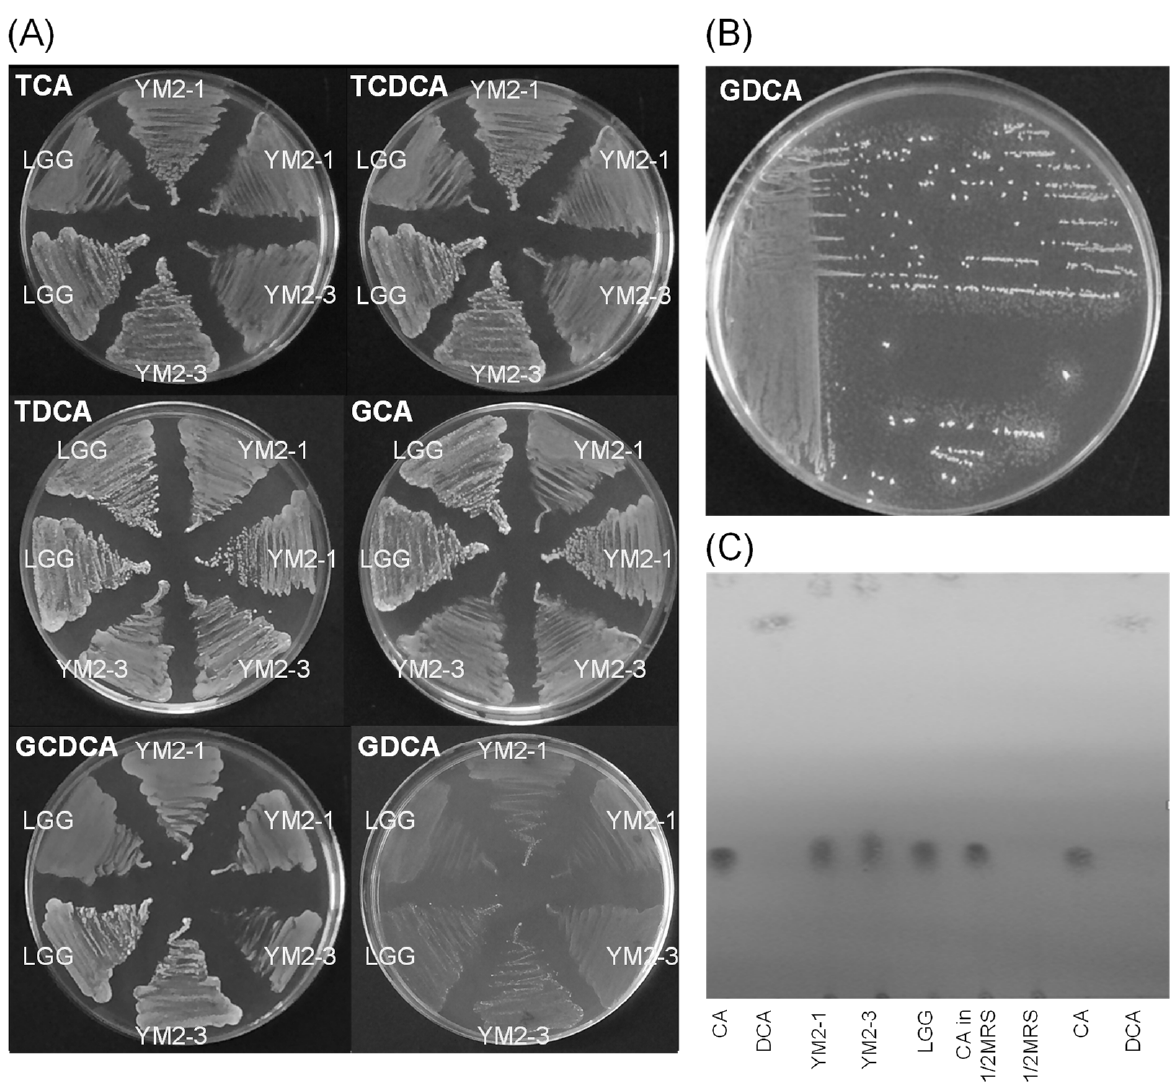
Figure 3. Effects of YM2-1 and YM2-3 strains on bile acid biotransformation. ( A ) Bile acid hydrolyz-